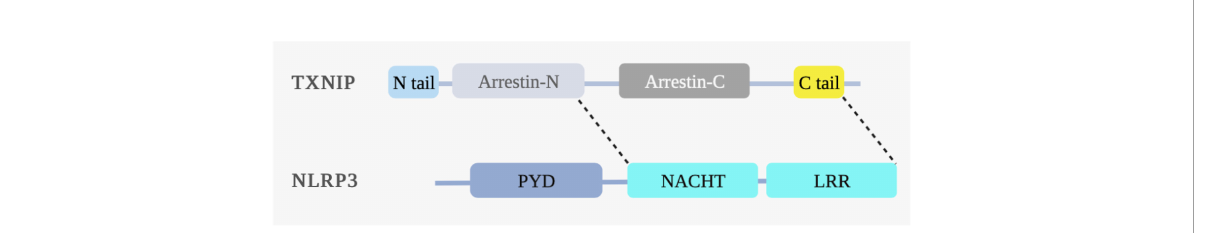
FIGURE 4 TXNIP binds to NLRP3 under ROS. ROS induces the interaction between the NLRP3 and TXNIP domains. The NLRP3 structural domains include the nucleotide-binding oligomerization domain (NACHT), pyrin domain (PYD), and leucine-rich repeat domain (LRR). The N-terminal arrestin (arrestin-N) domain of TXNIP interacts with the NACHT domain of NLRP3. The C-terminal carboxyl extension domain of TXNIP binds to the LRR domain of NLRP3, thereby activating the NLRP3 in fl ammasome under